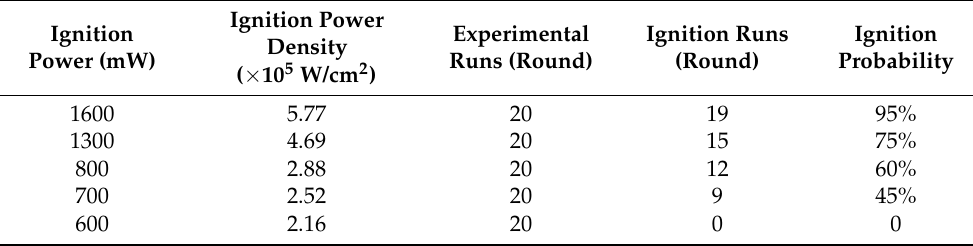
Table 1. Ignition probability of single Al-Li alloy microparticles at different ignition powers. Ignition Power Experimental Ignition Density Runs Power (mW) ( × 10 5 W/cm 2 )